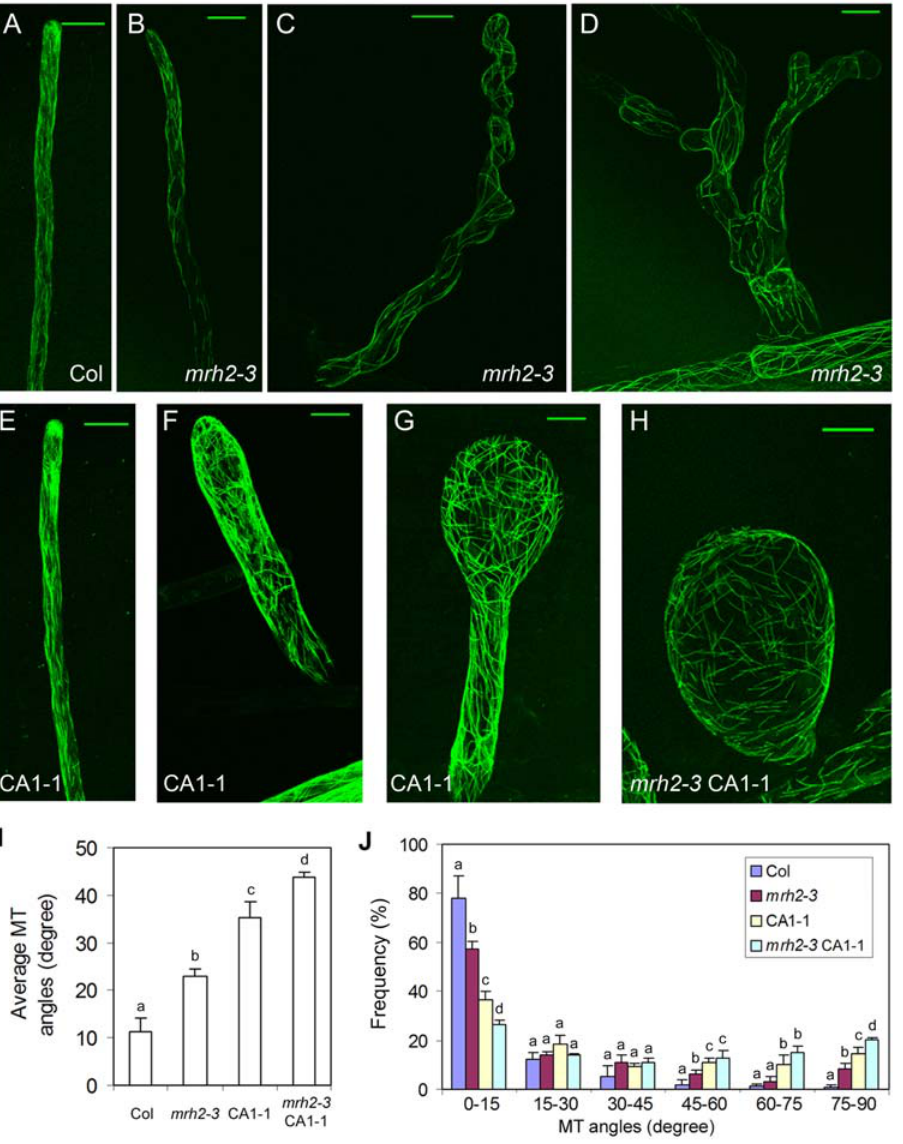
Figure 4. MT organization in mrh2-3, CA1-1, and mrh2-3CA1-1 root hairs. Representative GFP-MBD images in various genotypes that contain the 35S:GFP-MBD construct. Images were projections of 20–50 confocal sections, separated by 1 m m distance. The bar represents 20 m m. (A) Col. (B–D) MT images from three typical root hairs of mrh2-3 : slight waving (B), severe waving (C), and severe waving and branching (D). (E–G) MT images from root hairs showing three representative types of CA1-1 root hairs: normal hair (E), swelling hair (F) and hair with bulbous tip (G). (H) Bulbous root hair of mrh2-3 CA1-1. (I–J) Quantitative analysis of MT orientation. Angles of MT relative to the root hair growth axis were measured. (I) The average MT angles for each root hair were calculated to show the overall MT angles for single root hair. (J) Distribution of MT angles. The data represents the average of three replicates, each with a total of about 180 MTs from 3–7 root hairs. Different letters above the column indicate a statistical significant difference (p , 0.05) between genotypes within the same category.